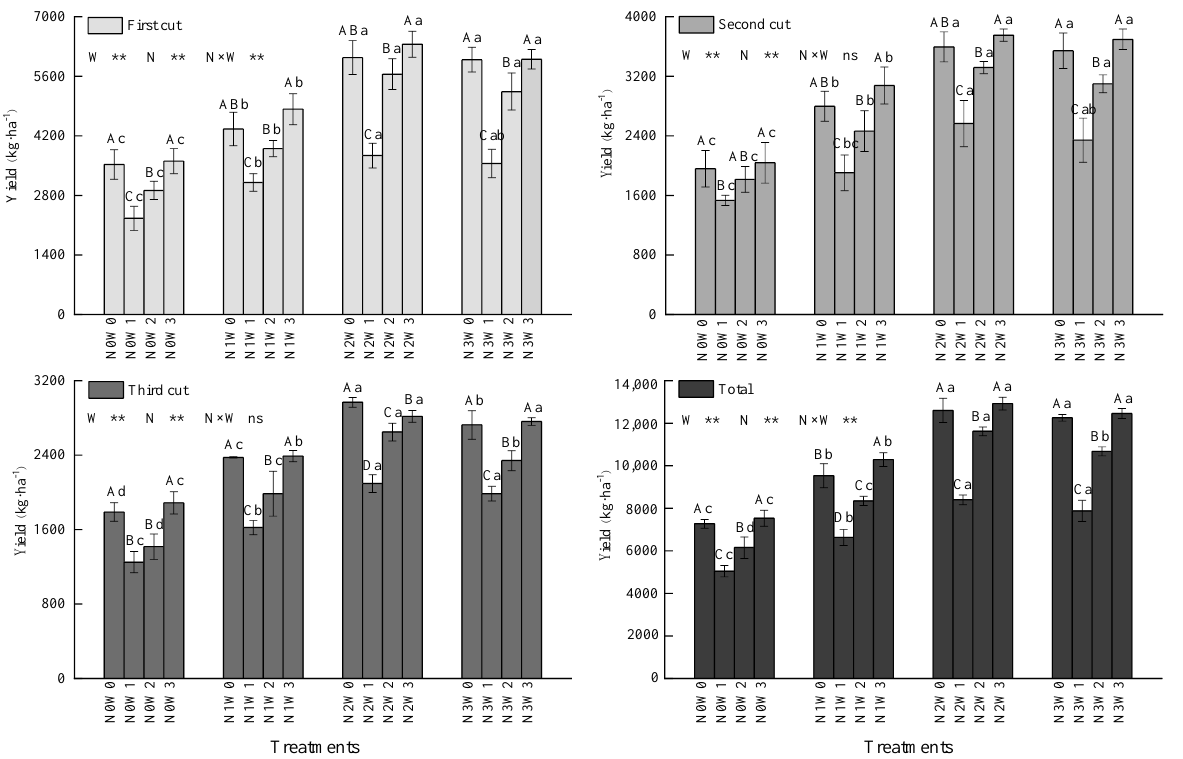
Figure 8. Effects of water-nitrogen regulation on yield of Bromus inermis . Different capital letters indicate the difference between different irrigation management types under the same nitrogen application level, and different lowercase letters indicate the difference between different nitrogen application levels under the same irrigation management ( p < 0.05). W and N refer to irrigation management and nitrogen application level, respectively; N × W refers to interaction effect between the two. ** indicates an extremely significant difference ( p < 0.01); ns indicates no significant difference ( p > 0.05).